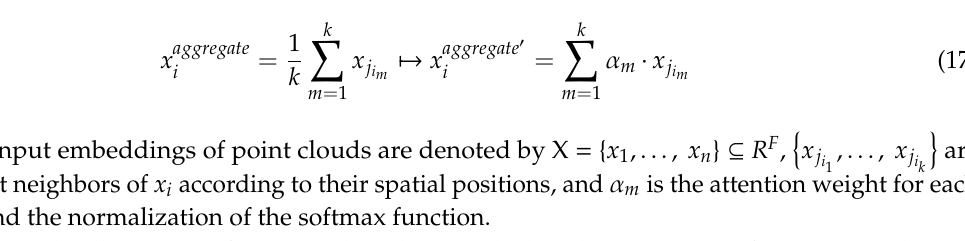
Figure 8. Illustration of the updator part. The skip connection is used to concatenate the output of the aggregator and the input embedding together. Finally, a fully connected (FC) layer follows to update and get the refined output embedding. The spatially independent trees are quickly and effectively separated, but the overlapping or adjacent trees are difficult to isolate. Several previous researches reduced omission errors by a certain graph-cut algorithm, which enhanced accuracy but increased computational complexity. To further segment those objects containing more than one object, a supervoxel-based normalized cut segmentation method is developed. The mixed objects are firstly partitioned into homogeneous supervoxels with approximately equal resolution using the existing over-segmentation algorithm proposed in [64], which can preserve the boundary of object much better than others. Then, consider a complete weighted graph G ( V , E ) constructed from the given supervoxels according to their spatial neighbors, where the vertices V are represented by the center of supervoxels, and edges E are connected between each pair of adjacent supervoxels. The meaningful weight assigned to the edge is